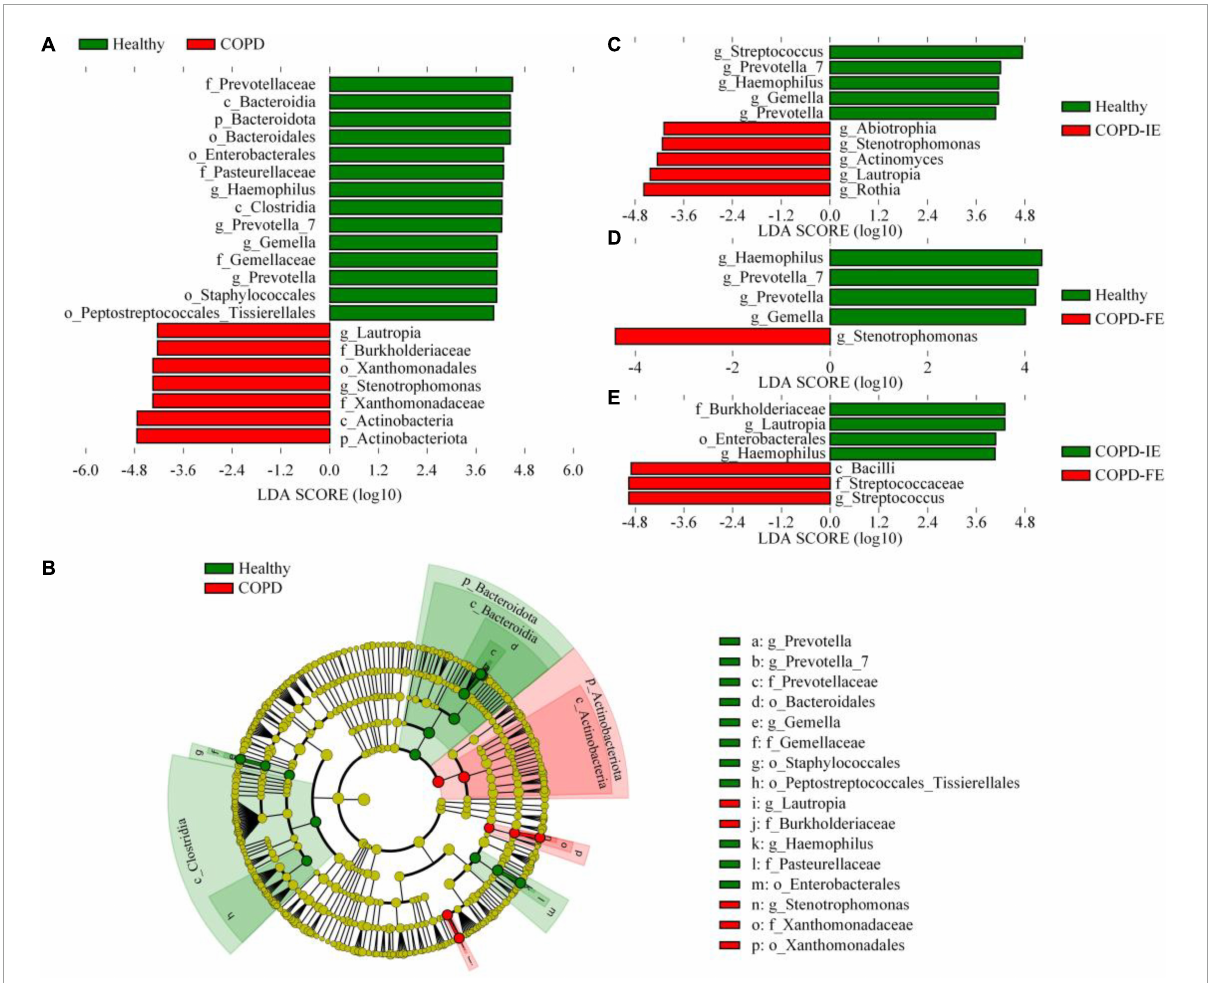
FIGURE5 The LEfSe test of sputum microbiome [LDA score (log10) = 4]. (A) Differentially distributed microbial taxa of all ranks between chronic obstructive pulmonary disease (COPD) subjects and healthy controls. (B) The phylogenetic profile of the specific differentially distributed taxa. (C–E) Differentially distributed genera between groups. Statistical significance was defined by p <